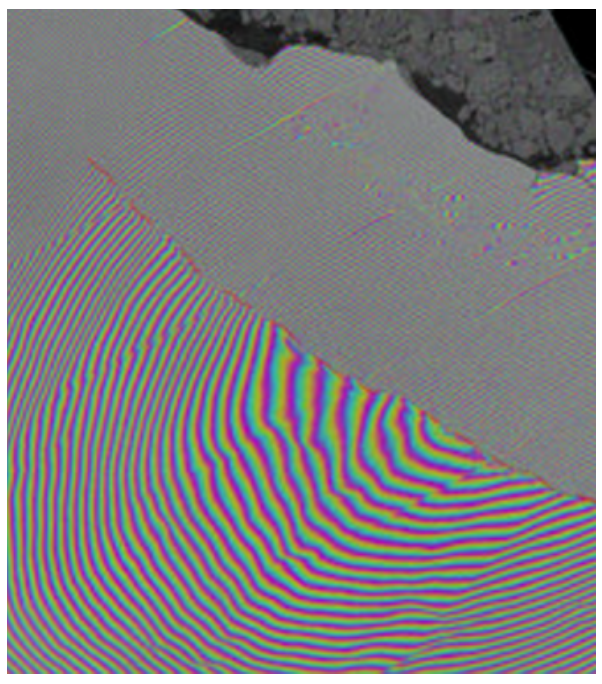
Figure A1. Interferometry (20 April 2017) in which two Sentinel-1 radar images from 7 and 14 April 2017 were combined to create an interferogram showing the growing crack in Antarctica’s Larsen C ice shelf. Polar scientist Anna Hogg said, “We can measure the iceberg crack propagation much more accurately when using the precise surface deformation information from an interferogram like this rather from than the amplitude (or black and white image) alone, where the crack may not always be visible.” Sourced from Agency (2017).